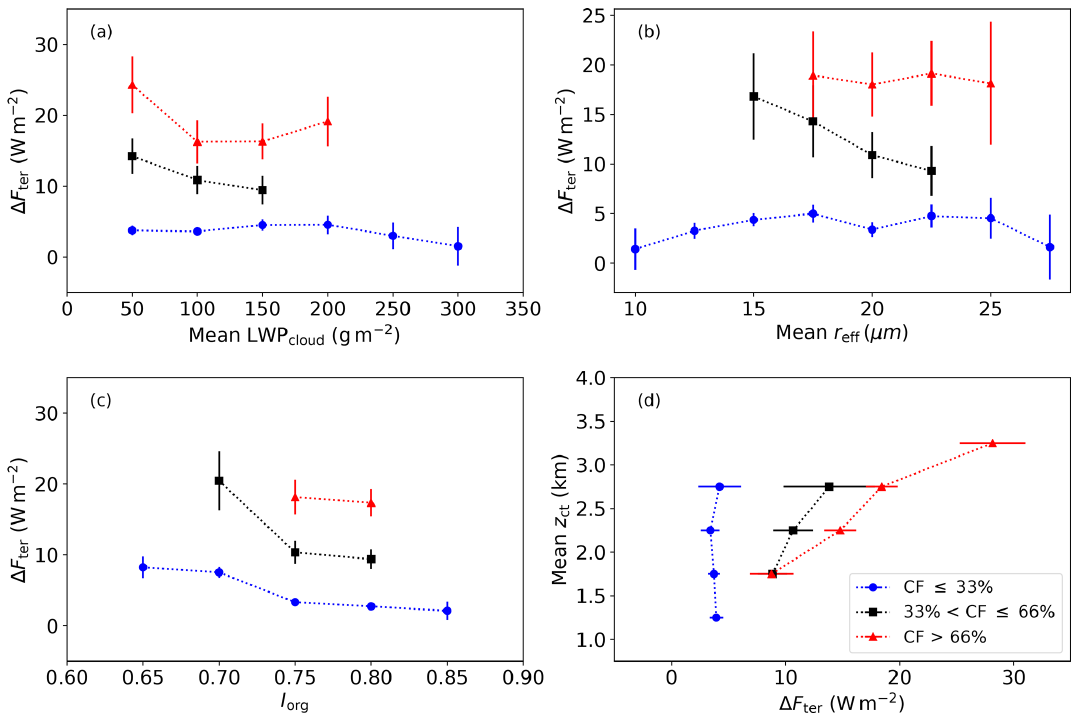
Figure 8. Same as Fig. 7 but for (cid:49)F ter